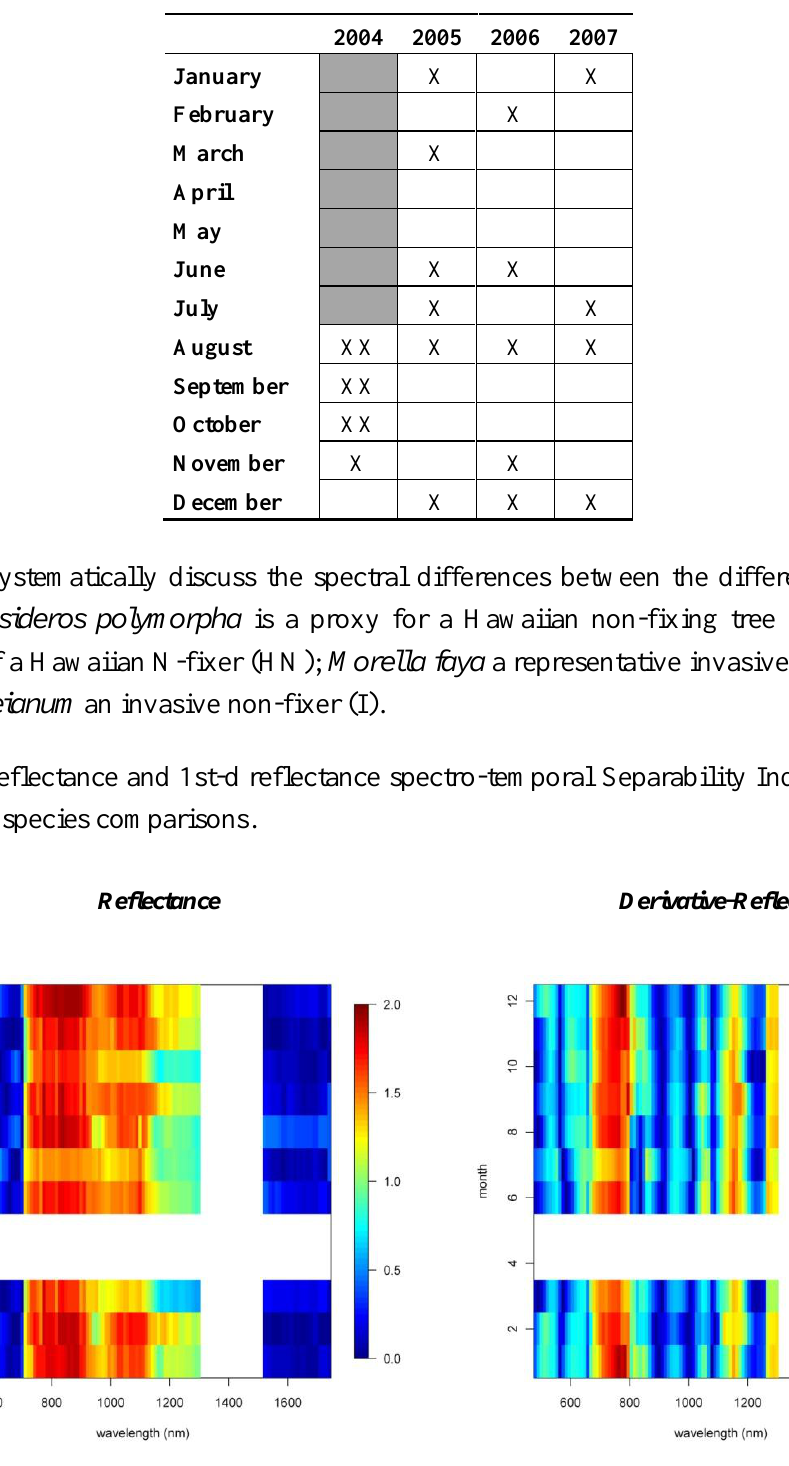
Table 1. EO-1 Hyperion imagery compiled into time series for this study.